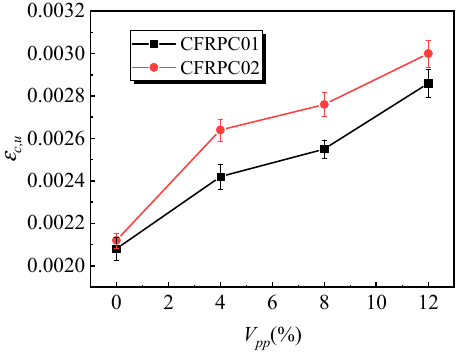
ff ect of the polymer–cement ratio on the peak compressive strain of the Figure 5. Effect of the polymer–cement ratio on the peak compressive strain of the specimens. Figure 5. E